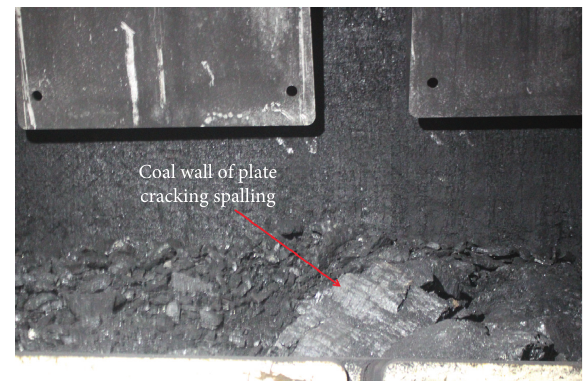
Figure 3: Plate cracking phenomenon in Jinjitan coal mine,